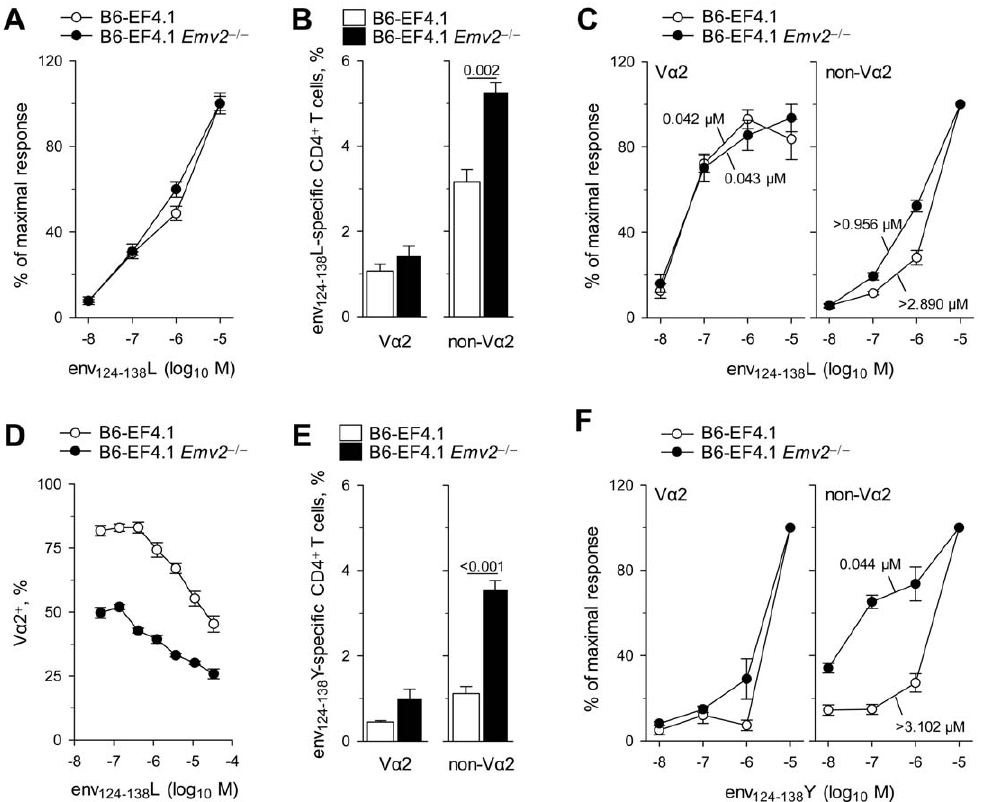
Figure 5. Emv2 preferentially selects against non-V a 2 env-specific CD4 + T cells. (A) Dose-response to env 124-138 L stimulation of CD4 + T cells isolated from either B6 (B6-EF4.1) or Emv2 -deficient B6 (B6-EF4.1 Emv2 2 / 2 ) EF4.1 mice. (B) Frequency of env 124-138 L-specific cells in V a 2 or non-V a 2 primary CD4 + T cells from the same donors. (C) Functional avidity of Emv2 -selected (B6-EF4.1) or -nonselected (B6-EF4.1 Emv2 2 / 2 ) EF4.1 CD4 + T cells for env 124-138 L. (D) Frequency of V a 2 cells in env 124-138 L-specific CD4 + T cells from the same donors as a function of peptide concentration. (E) Frequency of env 124-138 Y-specific cells in V a 2 or non-V a 2 primary CD4 + T cells from the same donors. (F) Functional avidity of Emv2 -selected (B6- EF4.1) or -nonselected (B6-EF4.1 Emv2 2 / 2 ) EF4.1 CD4 + T cells for env 124-138 Y. Numbers in (C) and (F) represent the ED 50 . Data in (A–F) are the means 6 SEM ( n =9–12) of 18-hr stimulations from 3 experiments.